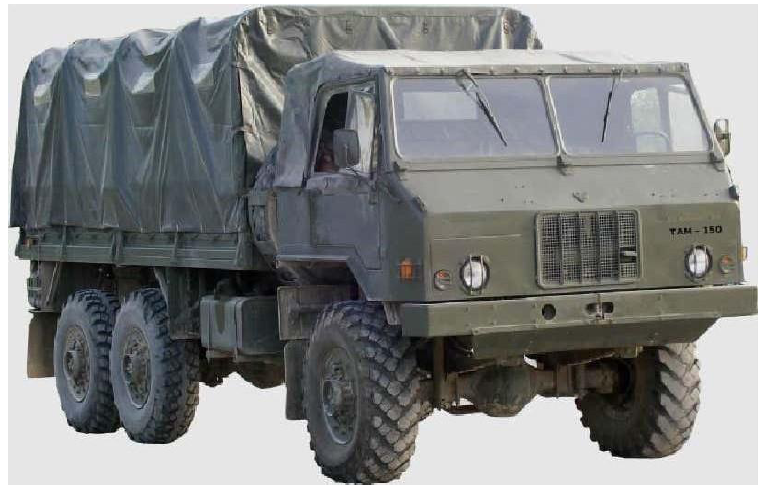
Figure 1 – All-terrain vehicle TAM 150 T11 Рис. 1 – Крупнотоннажный грузовой автомобиль ТАМ 150 Т11 Слика 1 – Теренско возило ТАМ 150